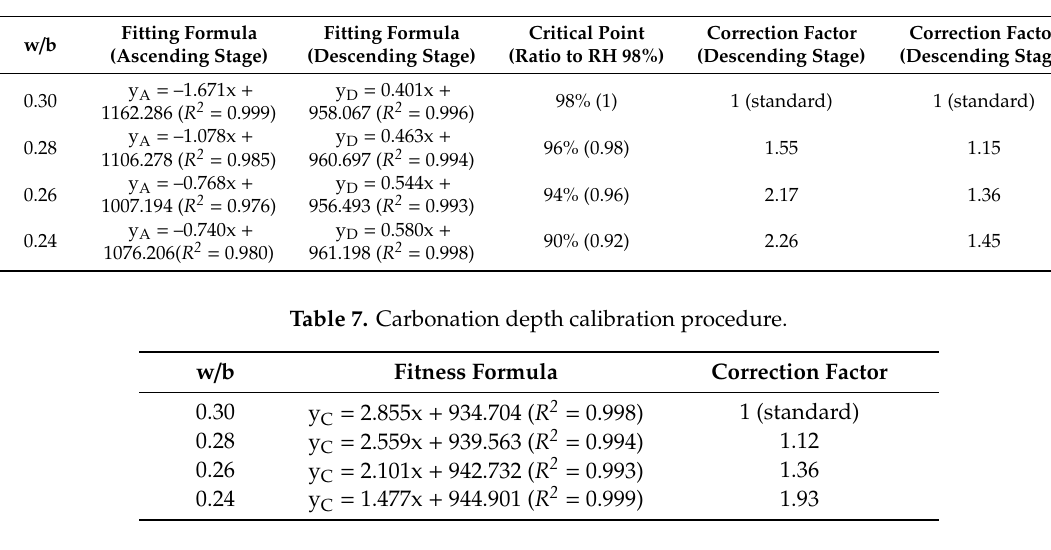
Table 6. RH calibration procedure.